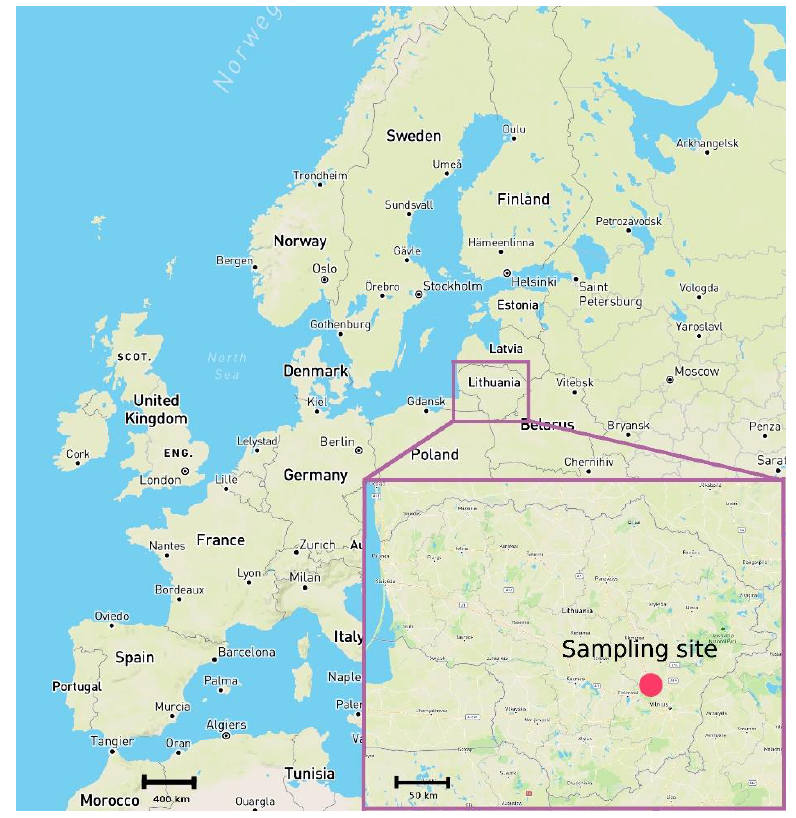
Figure 1. Map of Europe with the location of the farm (marked as red dot in the inset) in Lithuania.